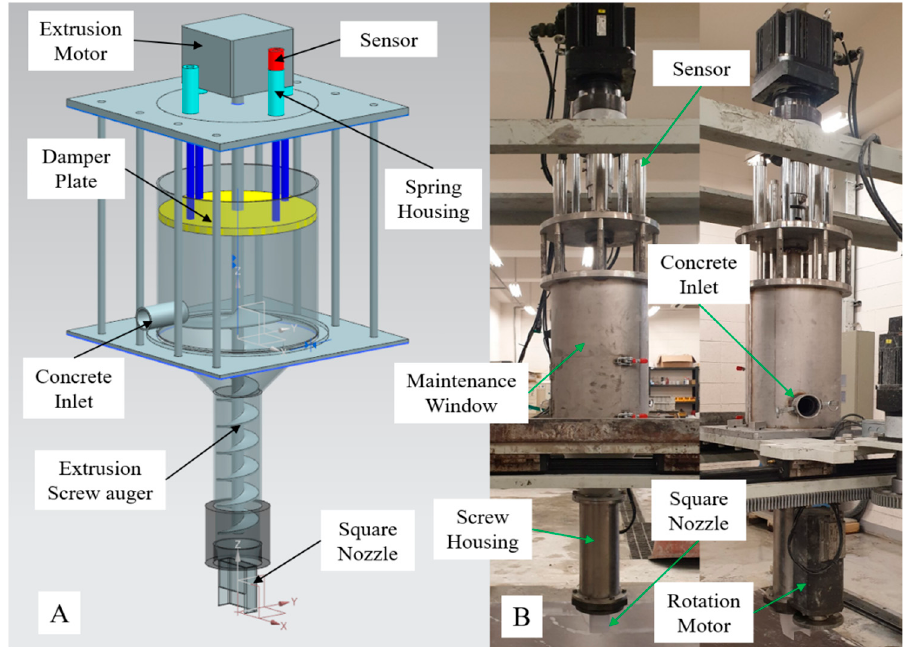
Figure 5. The extrusion module of 3DCP equipment: ( A ) concept model; ( B ) developed device.